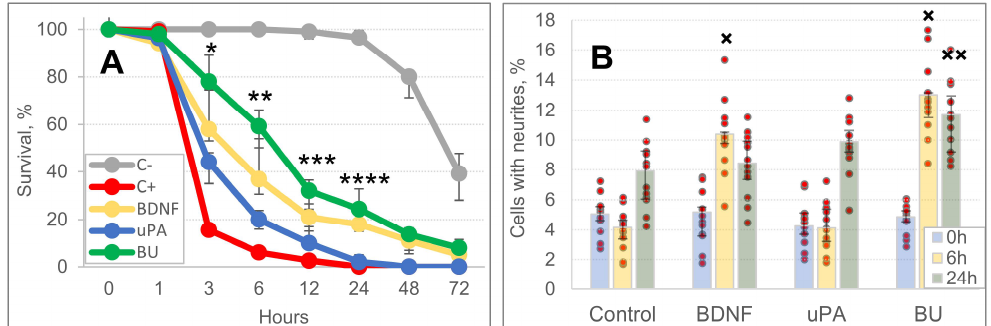
Figure 5. Brain-derived neurotrophic factor (BDNF), urokinase-type plasminogen activator (uPA) and their combination support the survival of SH-SY5Y neuroblastoma cells under glutamate-excitotoxic conditions ( A ) and stimulates neuritogenesis in SH-SY5Y cells ( B ). In ( A ), BDNF, uPA, and their combination (BU) significantly differ from the positive control (C+) group within the time range of 3–24 h: [*—H (3, 44) = 39.548, p = 0.001; **—H (3, 44) = 32.954, p = 0.001; ***—H (3, 44) = 24.681, p = 0.001; ****—H (3, 44) = 40.080, p = 0.001]. In (B), ×—H (3, 44) = 35800, p = 0.001; ××—H (3, 44) = 12.879, p = 0.005. Red dots on the diagram correspond to the result of individual measurements. All the comparisons were made versus the Control group value at the corresponding time point.